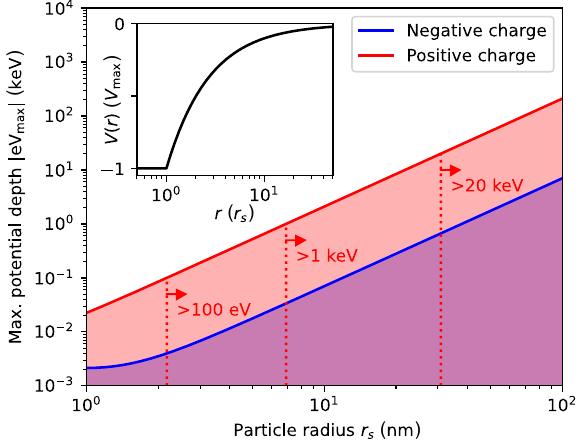
FIG. 7. The maximum depth of the electric potential energy, V max , for a positively (red) or negatively (blue) charged nanosphere of radius r s , assuming that the net charge is limited by field emission [99,139]. For β − decay, the red dashed lines and arrows indicate the nanosphere sizes for which an electron of a given initial kinetic energy could be stopped by a nanosphere charged to this limit. The inset shows the electric potential as a fraction of V max relative to a distant grounded surface as a function of the distance from the nanosphere center, r